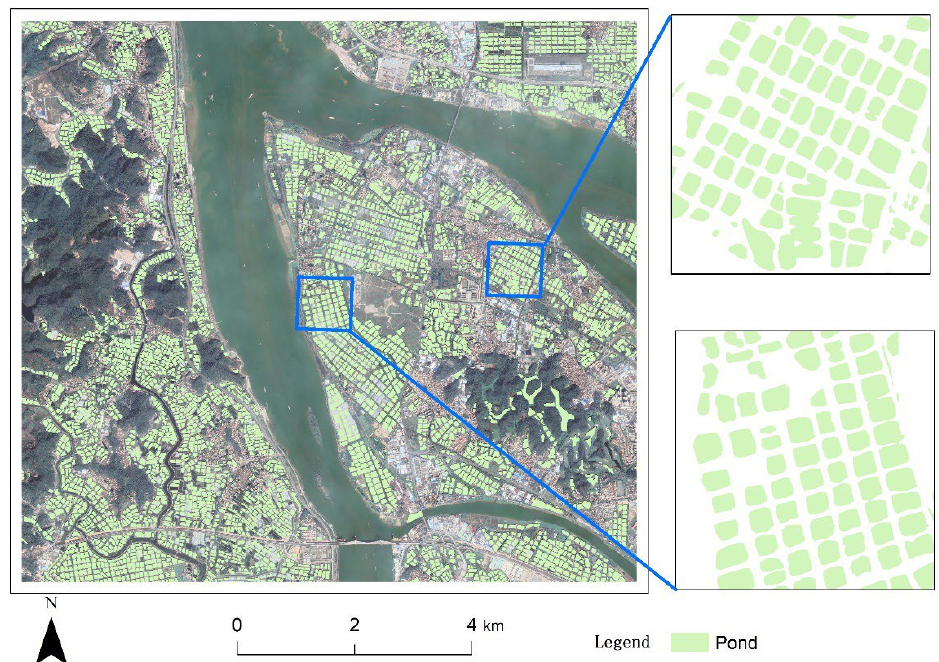
Figure 3. Mapping of ponds in the PRD (local spot, in Junan, Shunde District, Foshan City).